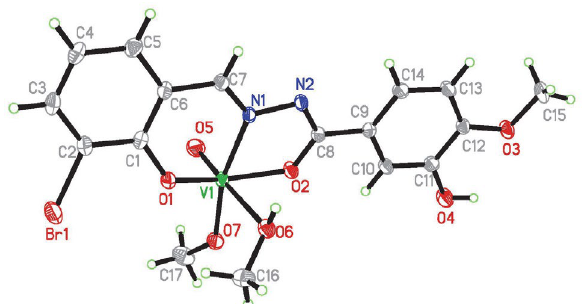
Figure 3. A perspective view of complex 1 with the atom labeling scheme. Thermal ellipsoids are drawn at the 30% probability level.